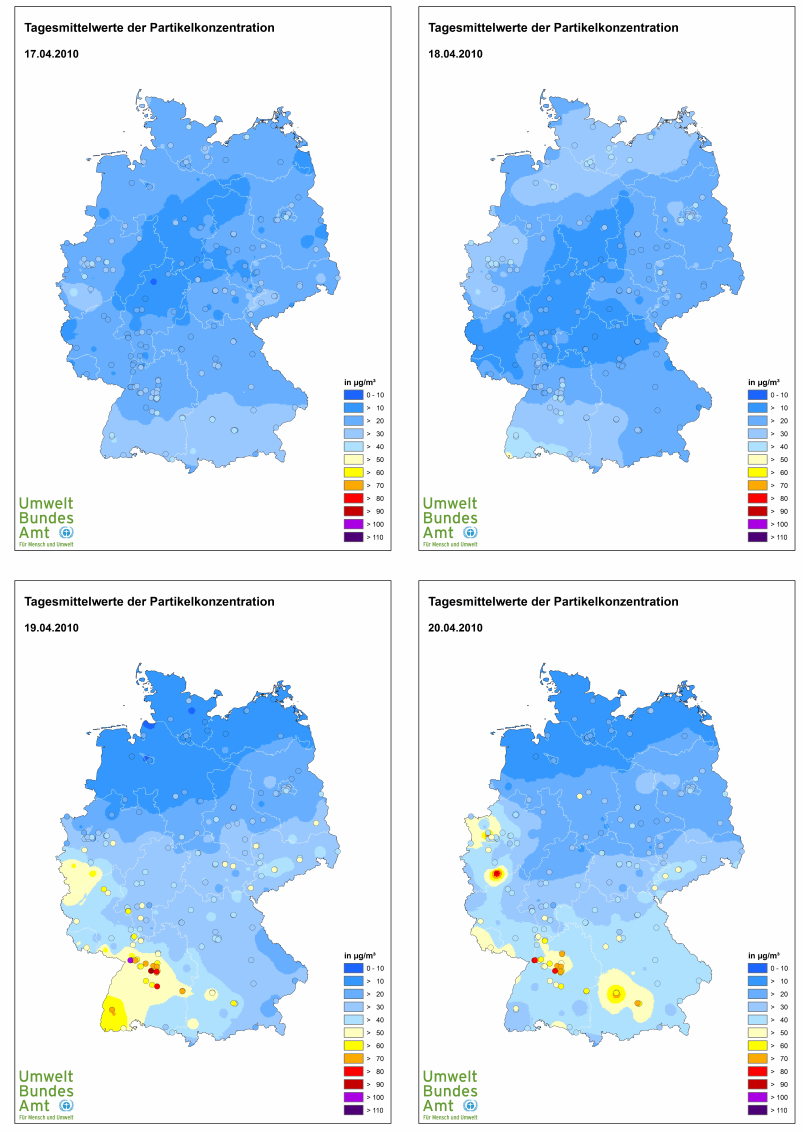
Fig. 5. Spatial distribution of daily mean PM 10 concentrations in Germany for the time period 17 April (upper panel left), 18 April (upper panel right), 19 April (lower panel left) and 20 April (lower panel right) on the basis of monitoring network data (German Umweltbundesamt – Federal Environment Agency of Germany, http://www.env-it.de/umweltbundesamt/luft-daten/index.html). The monitoring sites are indicated by circles. Different concentration ranges in µgm − 3 are given by different colours as indicated in the maps. The network does not include stations in higher Alpine regions, corresponding to the southern fringe of the